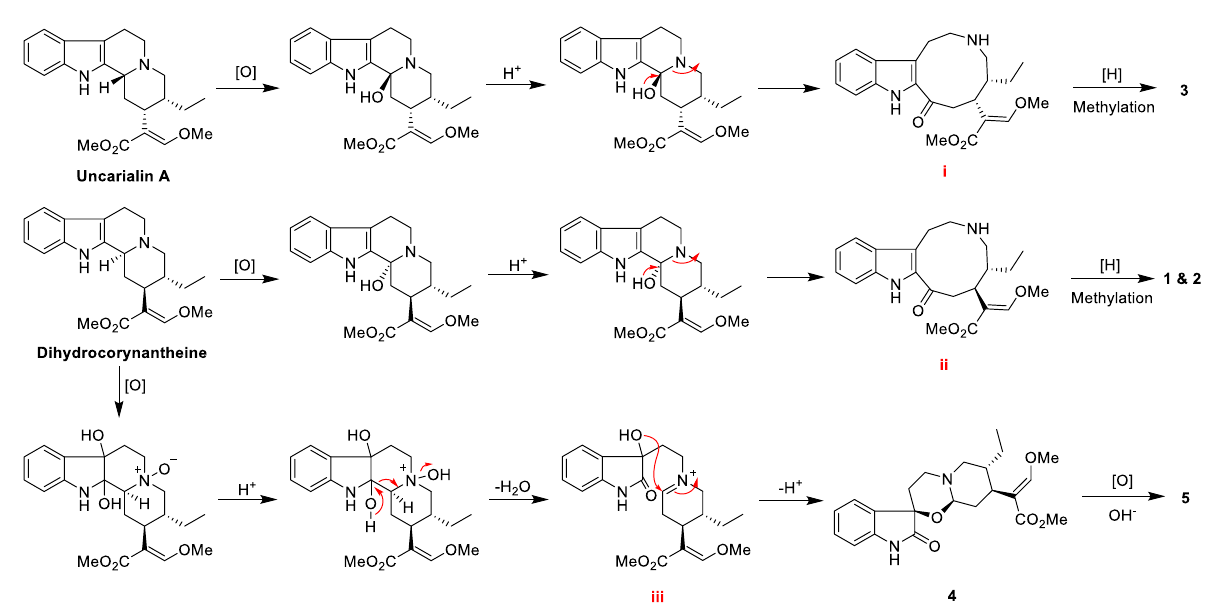
Table 3 Determination of the effects of compounds on blood clotting times of human plasma